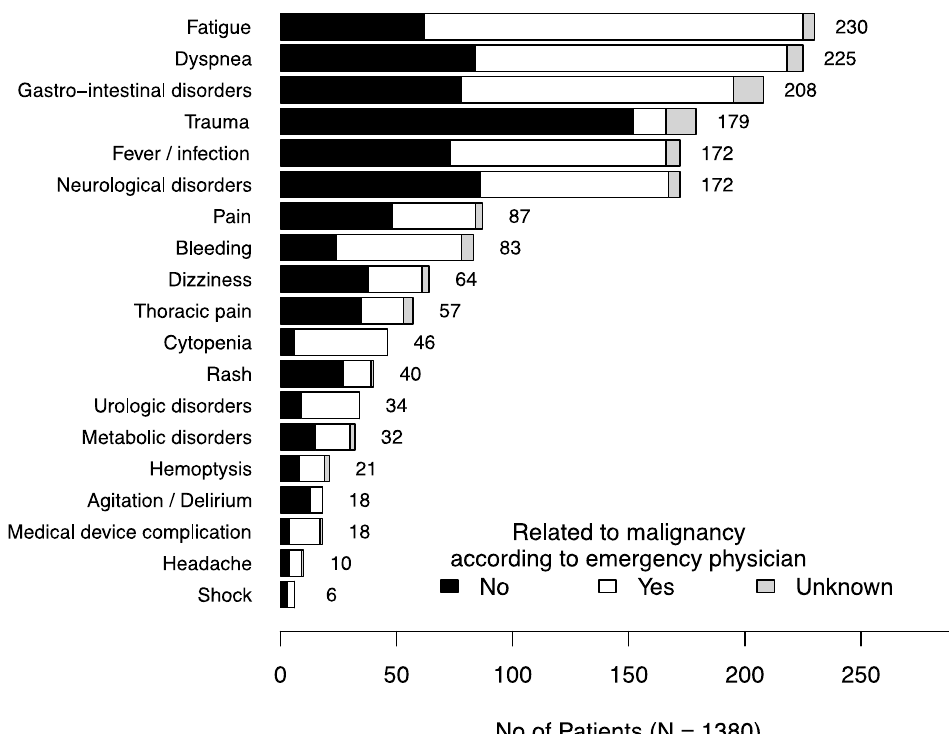
Table 3. Clinical severity of cancer patients upon emergency department presentation. Variables at ED Presentation